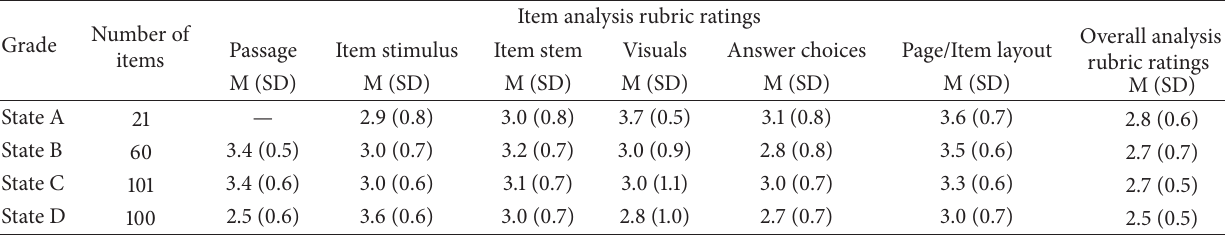
Table 4: Accessibility ratings for science items by